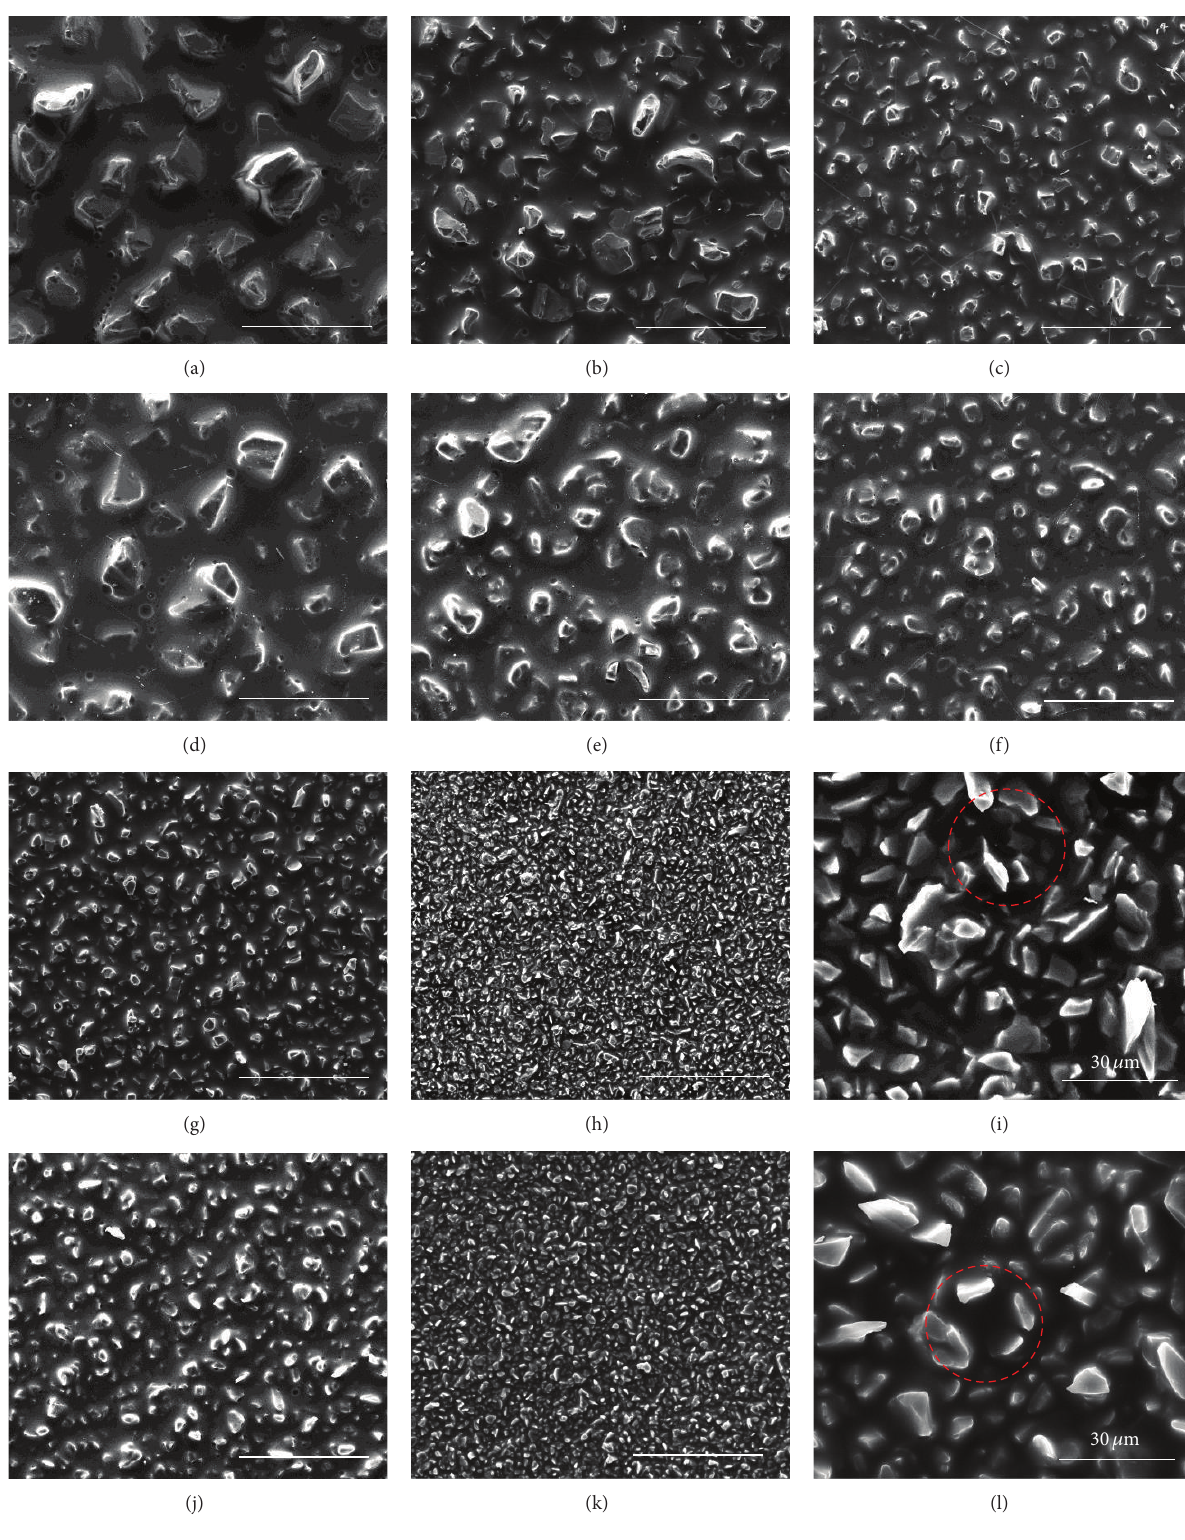
Figure 1: SEM images of sandpapers ((a) P240; (b) P400; (c) P600; (g) P1000; (h-i) P2000) and coatings ((d) P240; (e) P400; (f) P600; (j) P1000; (k-l) P2000). Scale bars are 200 𝜇 m unless otherwise